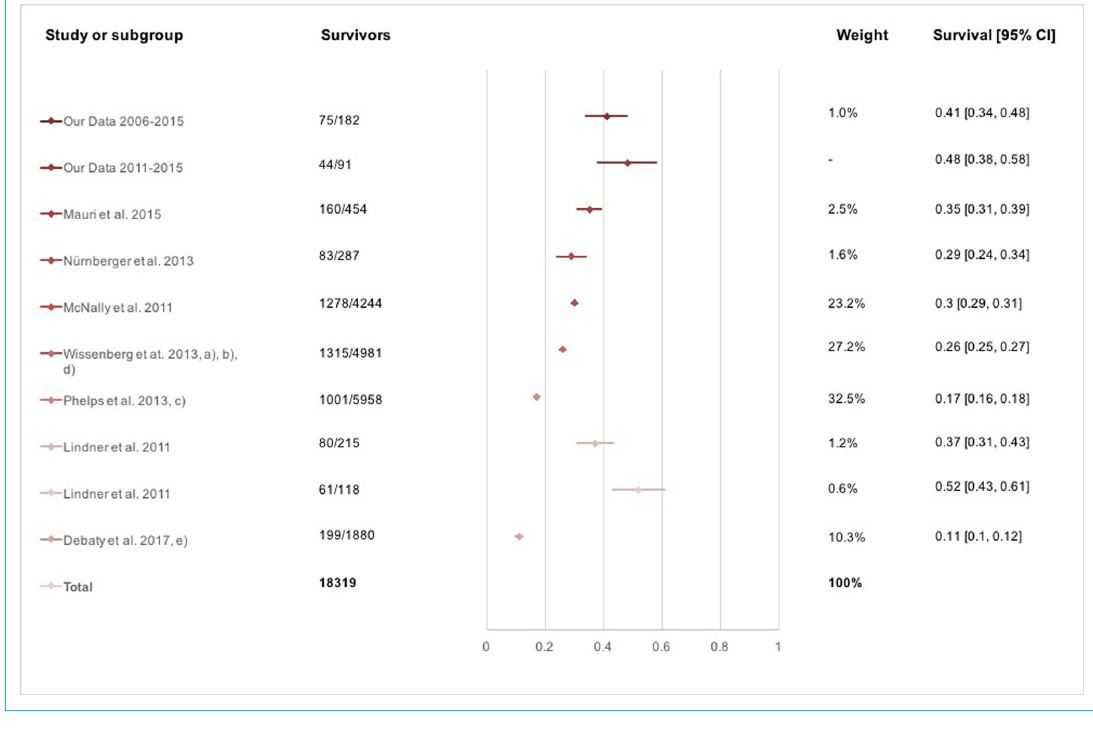
Figure 3: Survival at hospital discharge.* Outcomes are reported according to Utstein (cardiac aetiology, witnessed [layperson or EMS] and shockable initial rhythm), if not mentioned otherwise: (a) at 30 days post-discharge; (b) excludes EMS-witnessed; (c) includes non-witnessed, non-shockable; d) includes non-witnessed; (e) includes non-cardiac, non-witnessed, non-shockable, excludes EMS-witnessed.